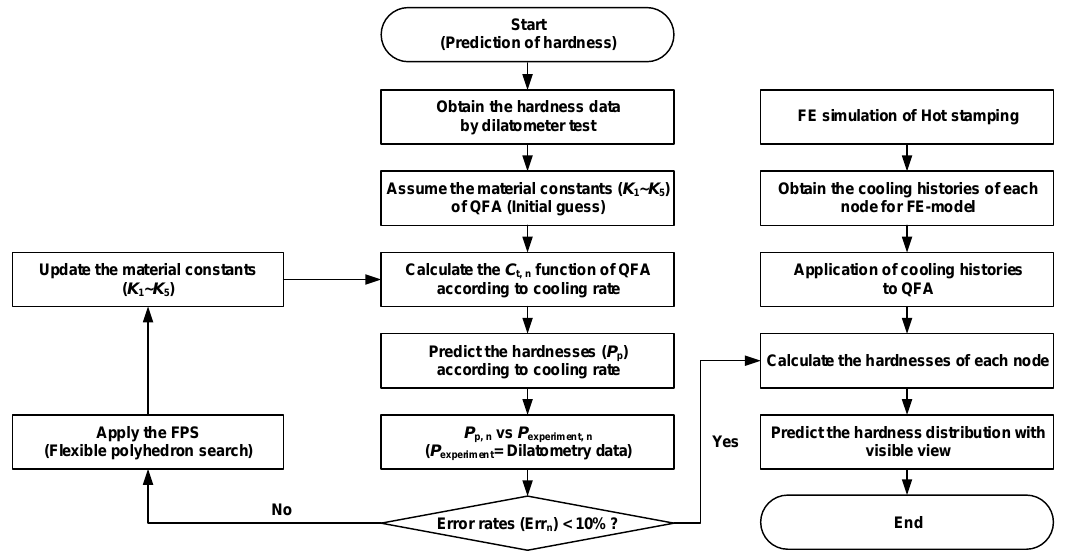
Figure 5. Flow chart for the prediction of the hardness coupled with finite-element (FE)-simulation.